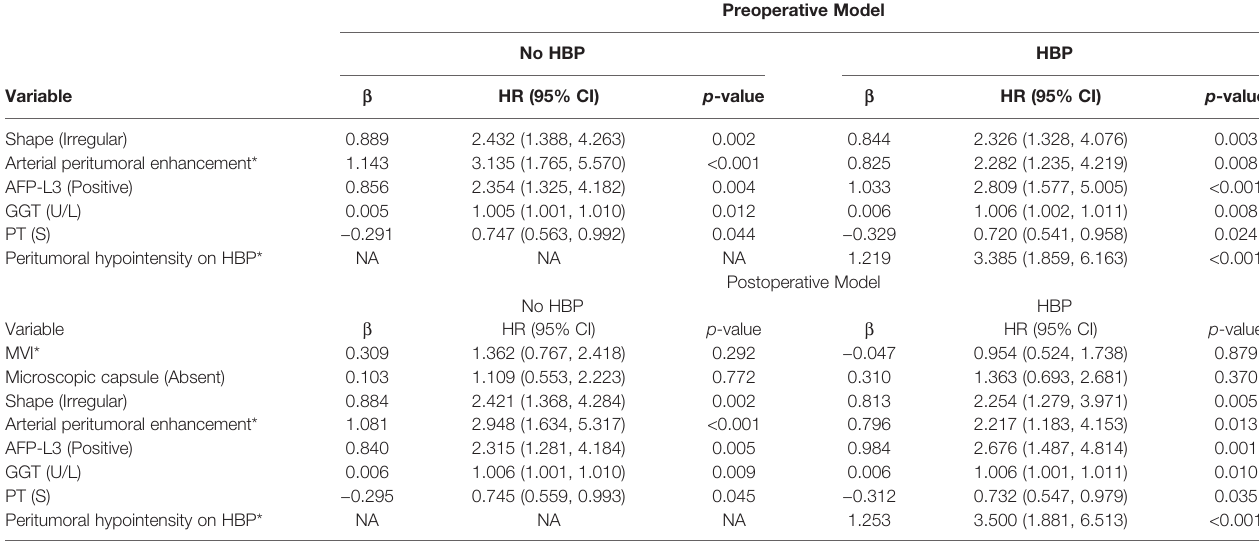
TABLE 3 | Multivariate Cox regression analysis for early recurrence.